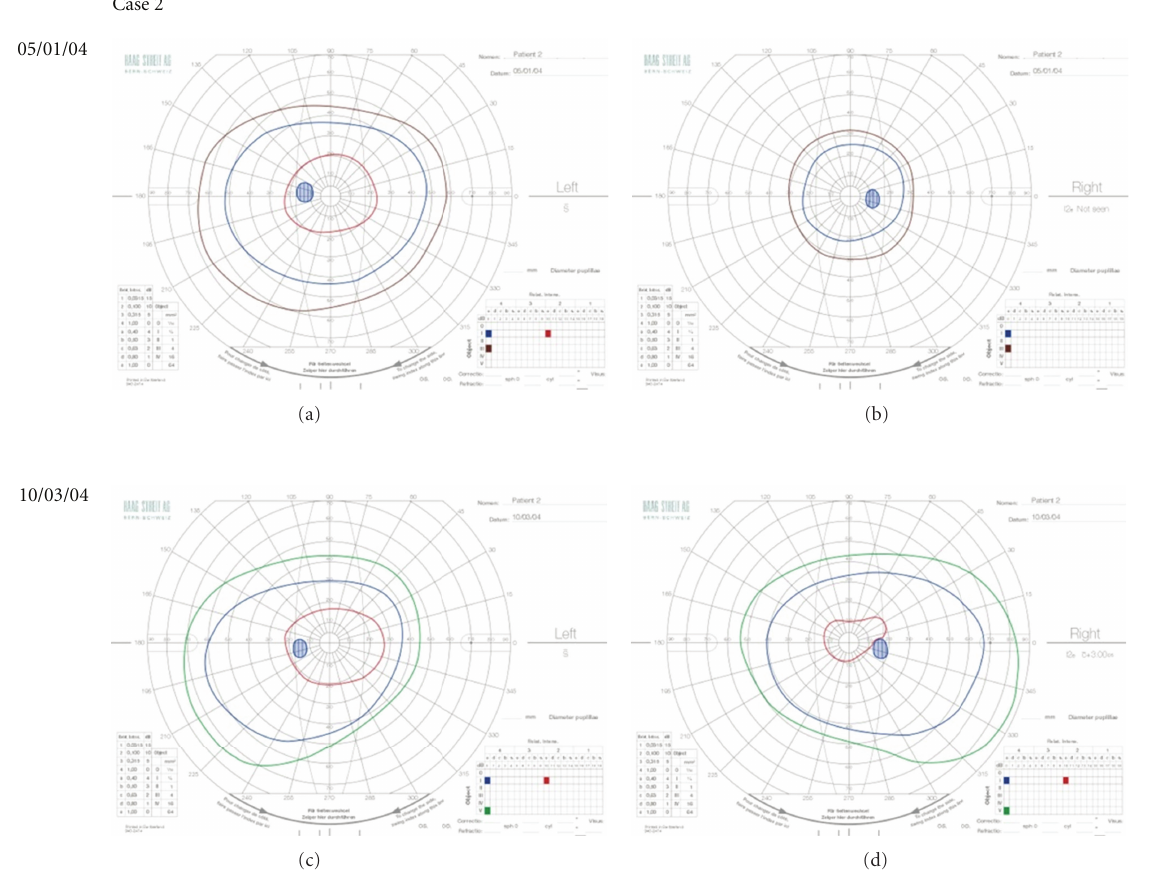
Figure 2: Goldmann visual fields performed on patient 2 at presentation of a recurrent episode of left retroorbital pain (a) and 2 months following treatment with intravenous methylprednisolone (c). The right eye had sustained an episode of optic neuritis previously (b and d).